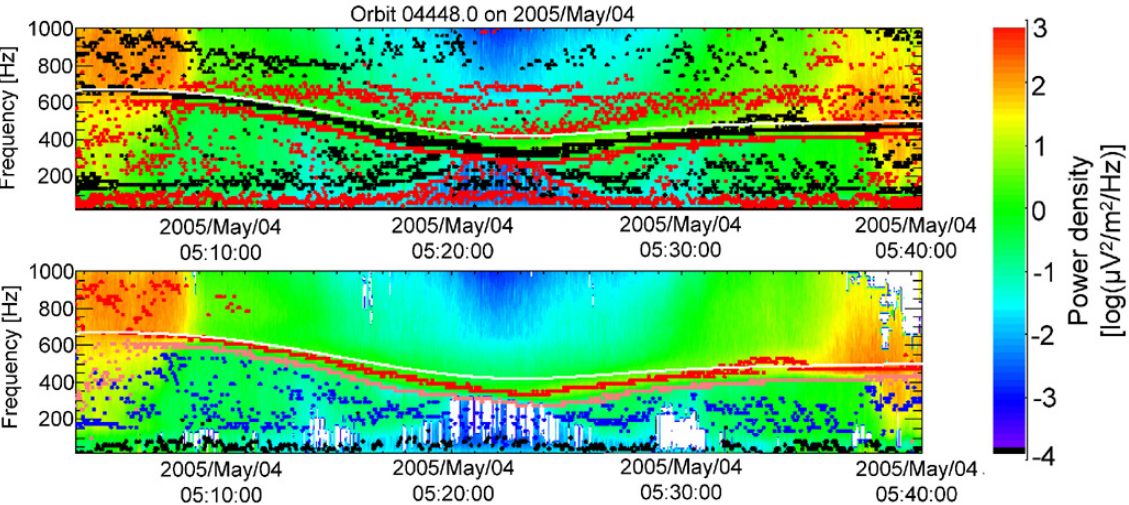
Fig. 2. Characteristic points detected on an ICE VLF spectrogram (top) and selected characteristic points for specific plasma emissions